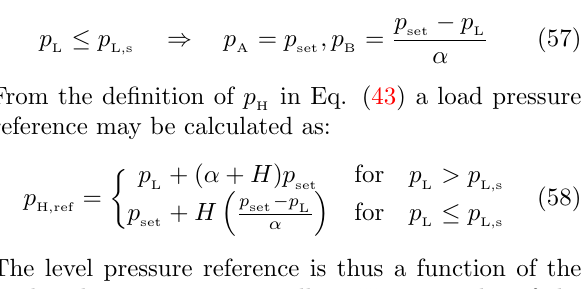
Figure 15: Examples of level pressure reference values as a function of load pressure evaluated us- ing Eq. (58) for different piston positions.